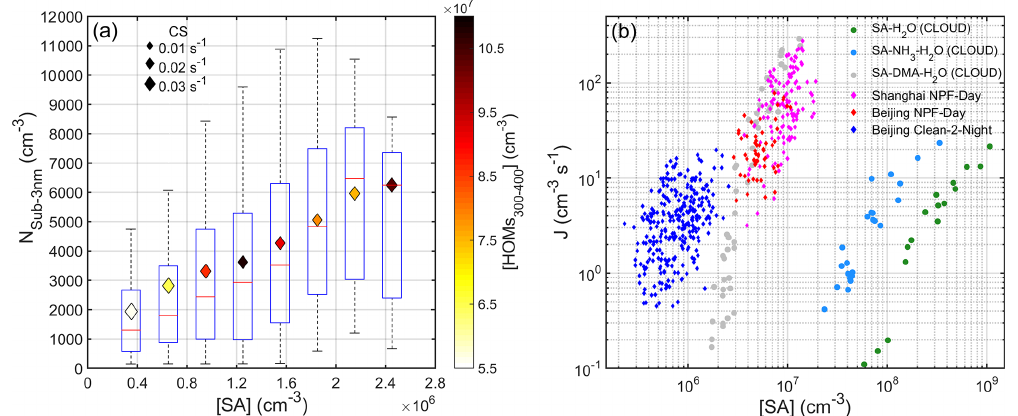
Figure 6. (a) Correlation between N sub-3nm and SA concentration during nighttime (20:00–04:00 next day) from 18 January to 15 March 2019. The binned diamonds are colored by number concentration of HOMs ( m/Q = 300 − 400Th), and the size is related to CS. The red line is the median value, the bottom and the top blue lines are the 25 and 75 percentiles, and the whisker ranges cover the ± 2.7 σ of those data in each bin. (b) Comparison of Beijing ambient, Shanghai ambient and CLOUD experimental cluster formation rates against SA concentration. Green, light blue and gray dots denote CLOUD J 1 . 7 data for SA-H 2 O, SA-NH 3 -H 2 O and SA-DMA-H 2 O nucleation respectively (Almeida et al., 2013; Kirkby et al., 2011). Magenta diamonds represent Shanghai NPF J 1 . 7 data (Yao et al., 2018). Red and blue diamonds are Beijing J 1 . 5 data for NPF day (10:00–14:00) and Clean-2 night (20:00–04:00),